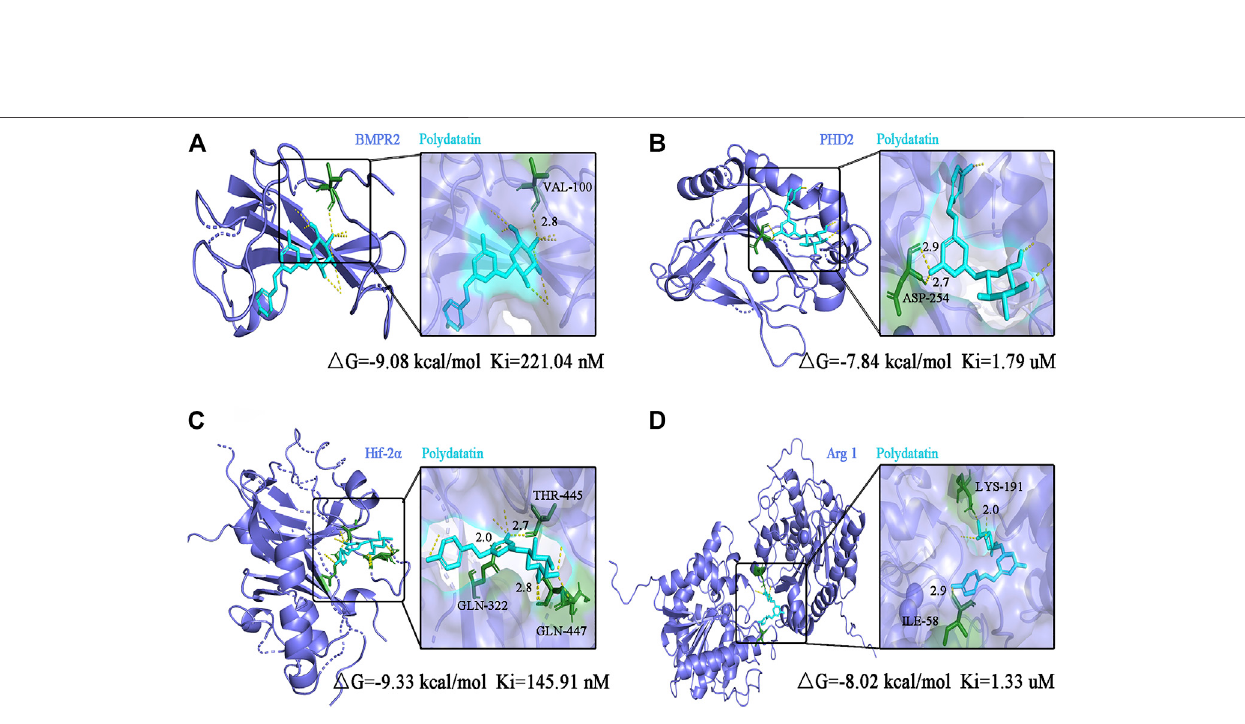
Frontiers in Pharmacology |